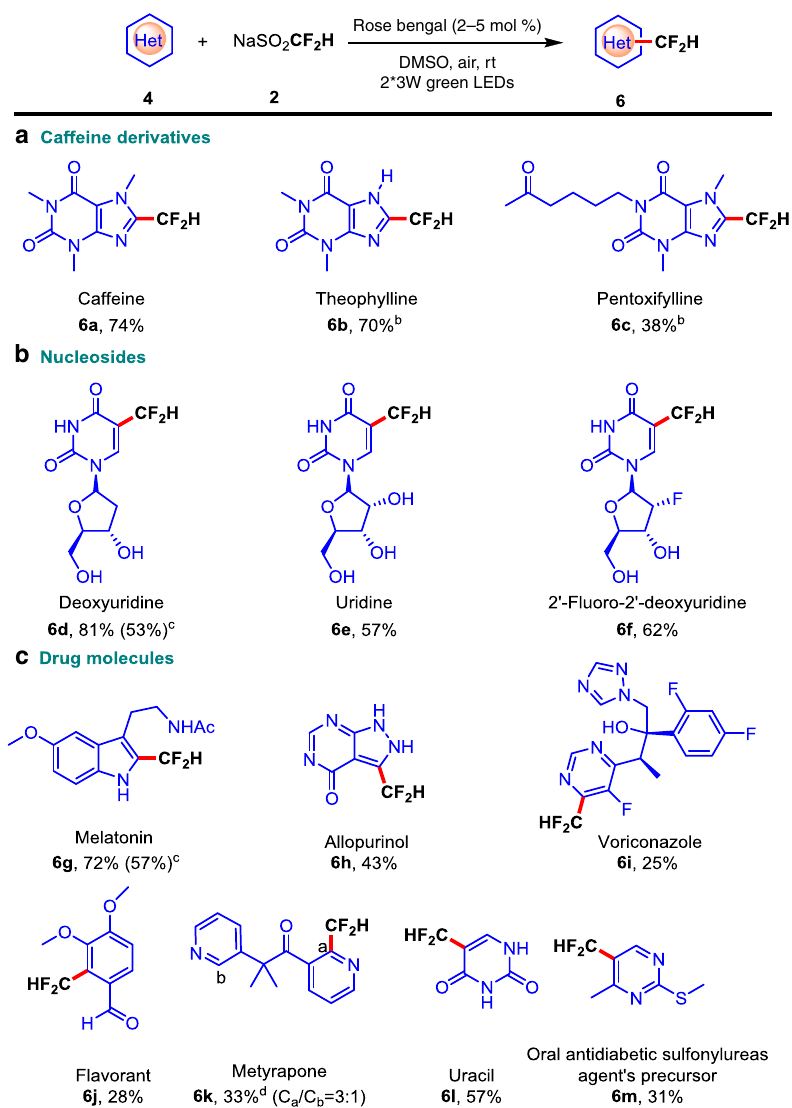
Fig. 4 Substrate scope of bioactive molecules. Reaction conditions: 4 (0.1 mmol), CF 2 HSO 2 Na 2 (0.4 mmol), rose bengal (5 mol%) in 1 mL DMSO under two 3 W green LEDs irradiation at room temperature. Isolated yields based on 4 . b With CF 2 HSO 2 Na 2 (0.4 mmol), rose bengal (2 mol%) in 1 mL DMSO. c Large scale with 2 mmol heteroarenes. d The minor regioisomeric position is labeled with the respective carbon atom